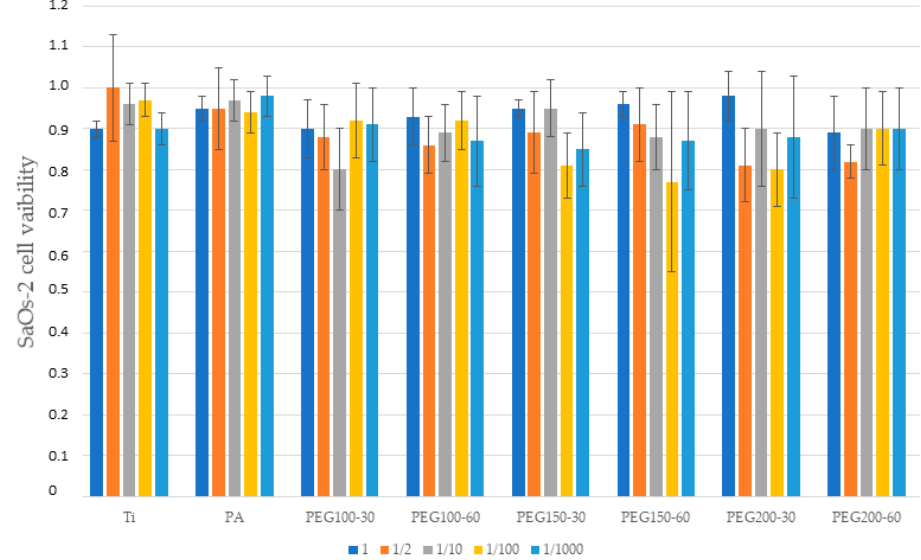
Figure 7. Cell viability of the SAOS-2 for the different treatments and different dilutions. Cell adhesion assays with hFFs (Figure 8) showed no difference between Ti, PA and PEG samples, whereas, for SAOS-2 (Figure 9), a slightly decrease was measured when the samples were polymerized.